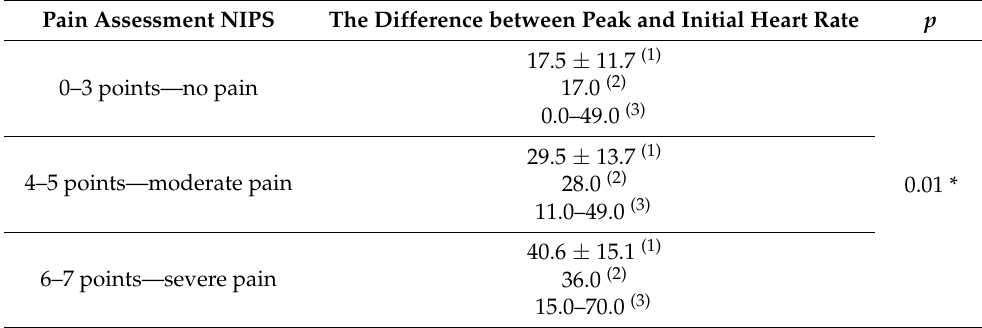
Table 7. The relationship between heart rate variability and pain assessment using NIPS.